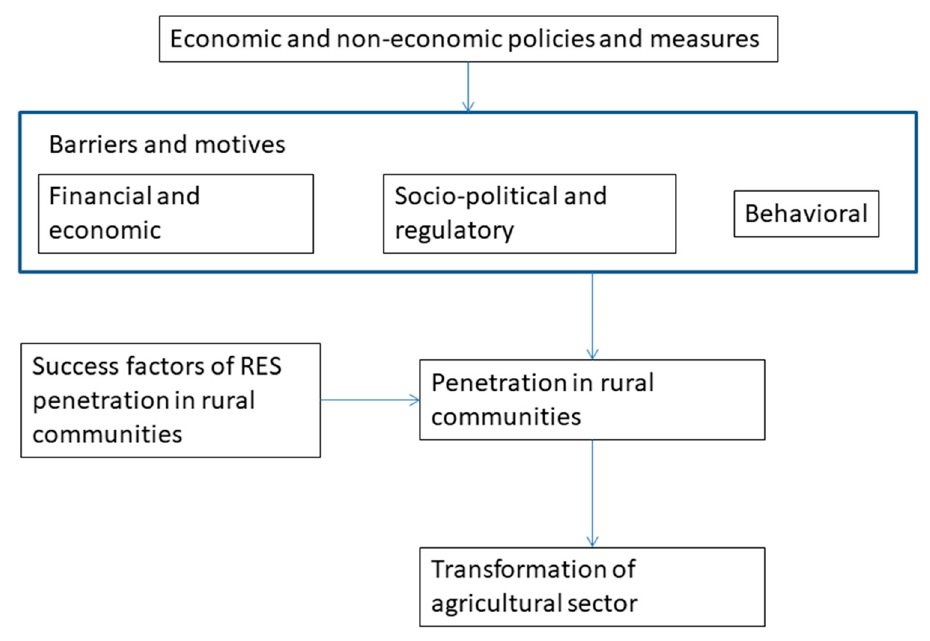
Figure 2. The main drivers and motives of renewable energy penetration in rural areas. Source: created by the authors.